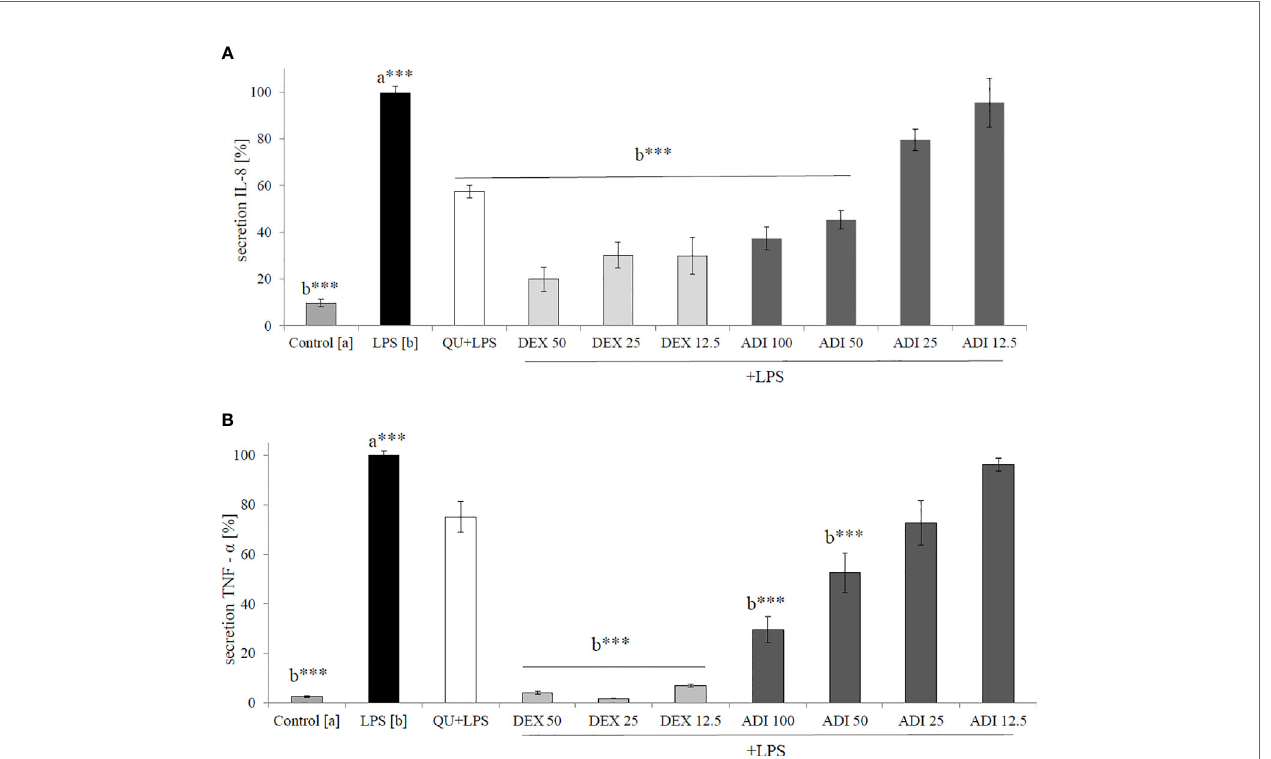
FIGURE 3 | Effect of ADI at concentrations of 12.5 - 100 µg/mL on (A) IL-8 production and (B) TNF- a production by LPS-stimulated neutrophils [%], mean ± SEM. Positive controls quercetin (QU) at a concentration of 50 µM and dexamethason (DEX) at concentrations 50, 25, and 12.5 µM. Statistical signi fi cance of differences was established by ANOVA with post hoc test, ***p < 0.001, a*** - statistical signi fi cance of differences between LPS-stimulated control compared to control, b - compared to the stimulated control